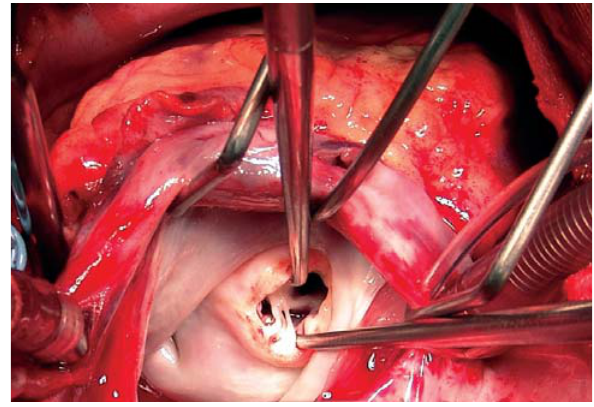
Fig. 2 – Aspecto reumático da valva mitral com fusão comissural ântero-lateral previamente à comissurotomia e ao implante do anel de